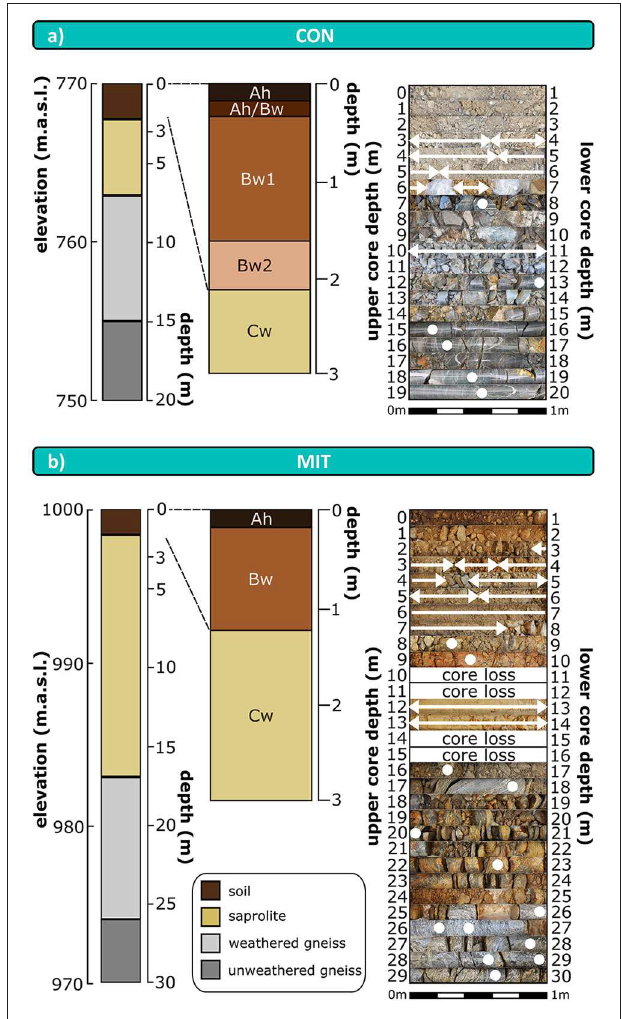
FIGURE 2 | Schematic depth distribution of drill cores and soil profiles (left hand side); stacked photographs of drill core sections with labeled sampling points and sampled depth intervals (right hand side) at CON (a) and MIT (b) . Arrows and cycles illustrate sampling points and depth intervals, respectively. Sampled depth intervals were selected to correspond to drill sections and changes in regolith appearance. Polyethylene bags at CON between 6 and 7m depth contain coherent regolith. m.a.s.l.: meter above sea level. Ah, Bw, Cw: soil horizons according to IUSS/ISRIC/FAO 2006. Boundary of soil to saprolite is defined to be represented by the boundary between Bw horizon to Cw horizon. Color scheme of schematic drill cores is used in subsequent profile figures to assign data to soil, saprolite, and